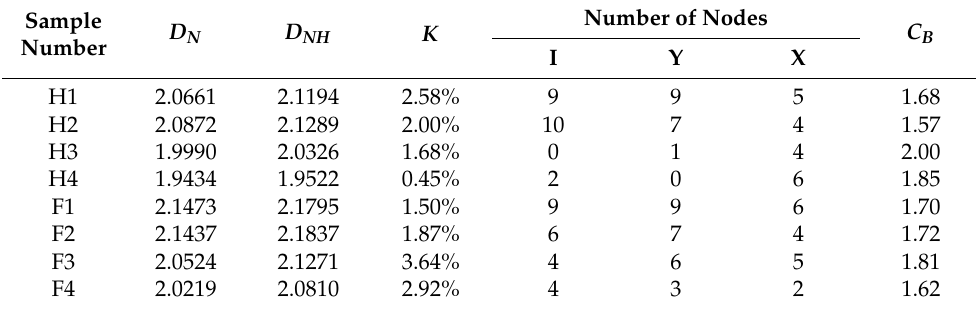
Table 3. The fractal dimensions and topological parameters of 3D